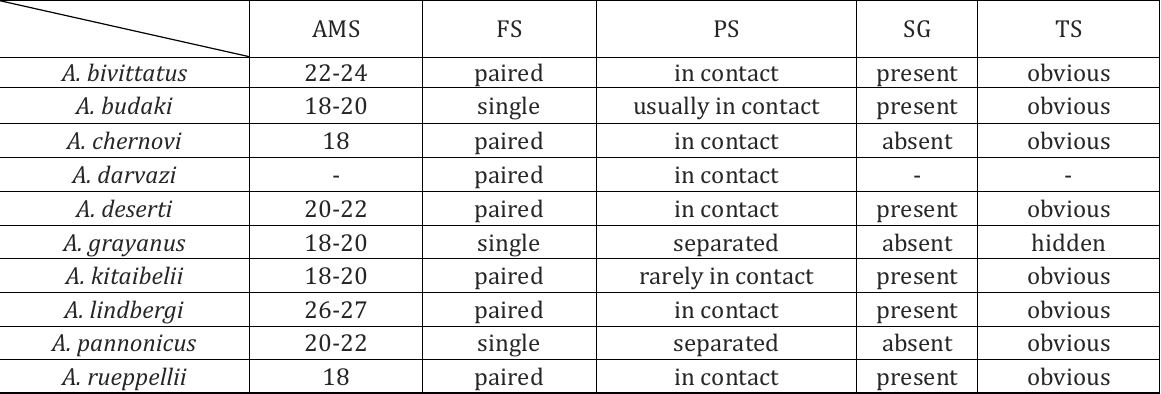
Table 1. The main morphological characters in various species of the Snake-eyed Skink Ablepharus Fitzinger, 1823: Number of scales around mid-body (AMS), frontoparietal scales (FS), Prefrontal scales (PS), Supraciliary granular scales (SG), Tympanum status (TS) (Strauch, 1868; Fühn 1969a; Göçmen et al., 1996; Kumlutas et al., 2005; Karamiani et al., 2015; Karamiani et al., 2018b; Özkan et al.,